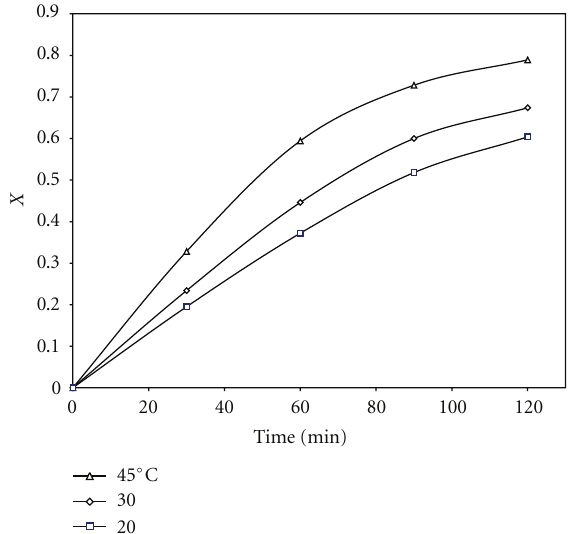
Figure 1: E ff ect of catalyst concentration on degradation of wastewater at two typical irradiation times: pH = 6.5 and T = 20 ◦ C.